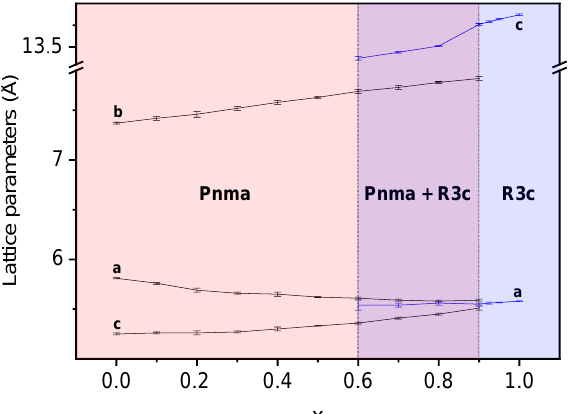
Figure 4. Unit-cell parameters with corresponding errors for the orthorhombic Pnma (S. G. No. 62) and rhombohedral R3c h (S. G. No. 161) phases in the (1 − x)YMnO 3 –xBiFeO 3 system.